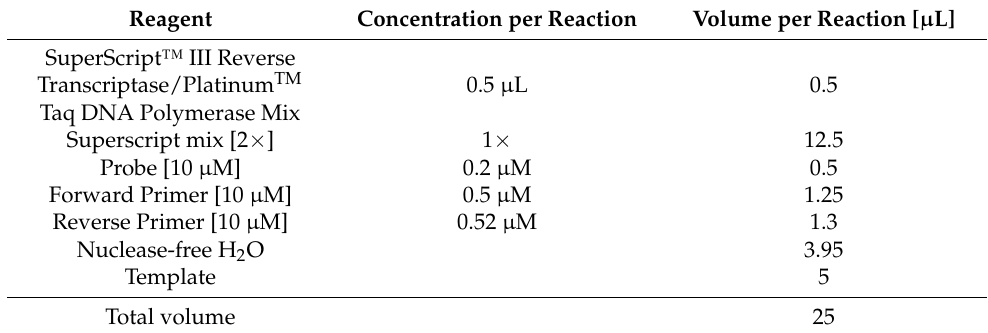
Table A2. Master mix set-up for the qRT-PCR.